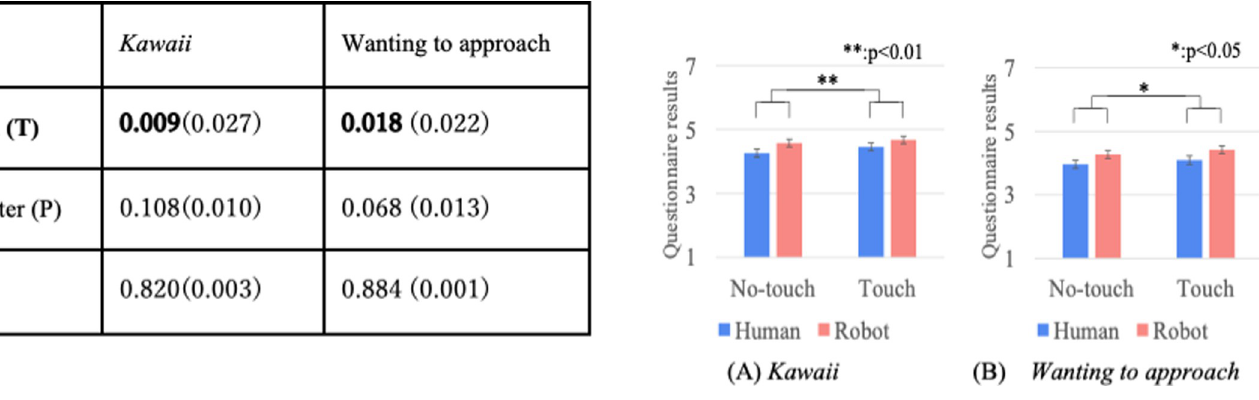
Fig 12. Participants’ feelings of kawaii and wanting to approach doll.